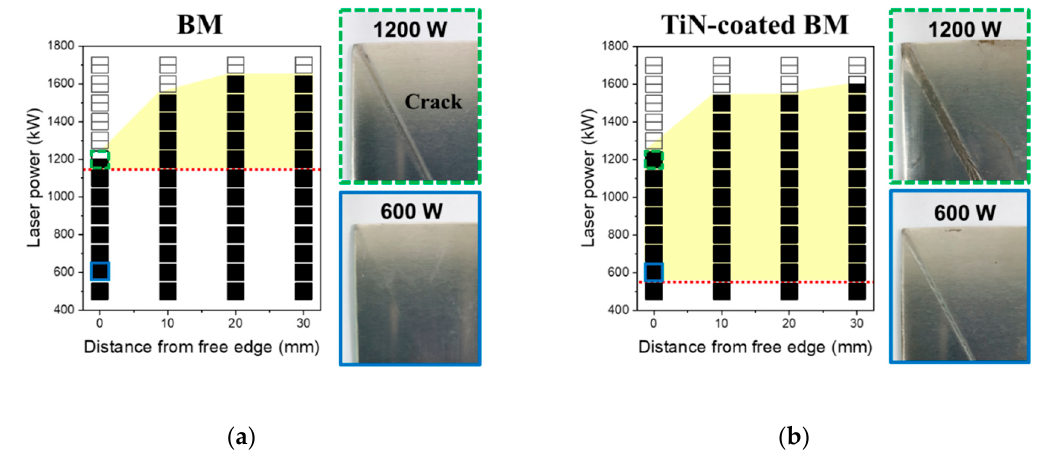
Figure 4. Free edge test data using ( a ) BM and ( b ) TiN-coated BM. The photos representatively show the back bead tested under the same condition except for the power at 1200 W (above) and 600 W (below).